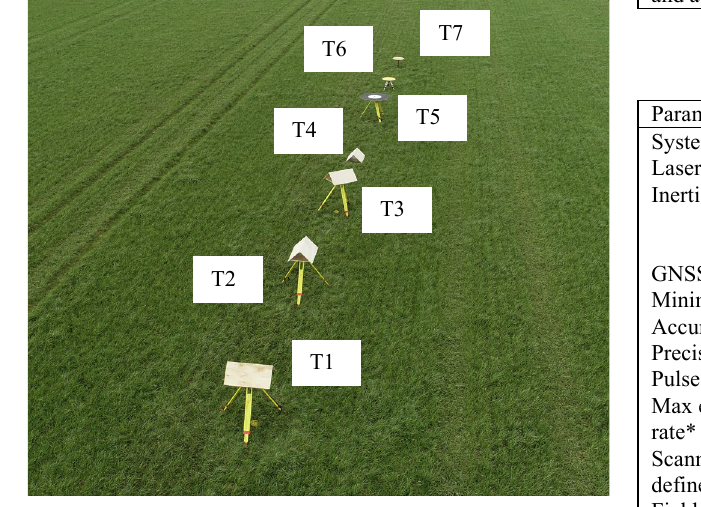
Figure 4. Targets T1 to T7, placed linearly at 5 m intervals.